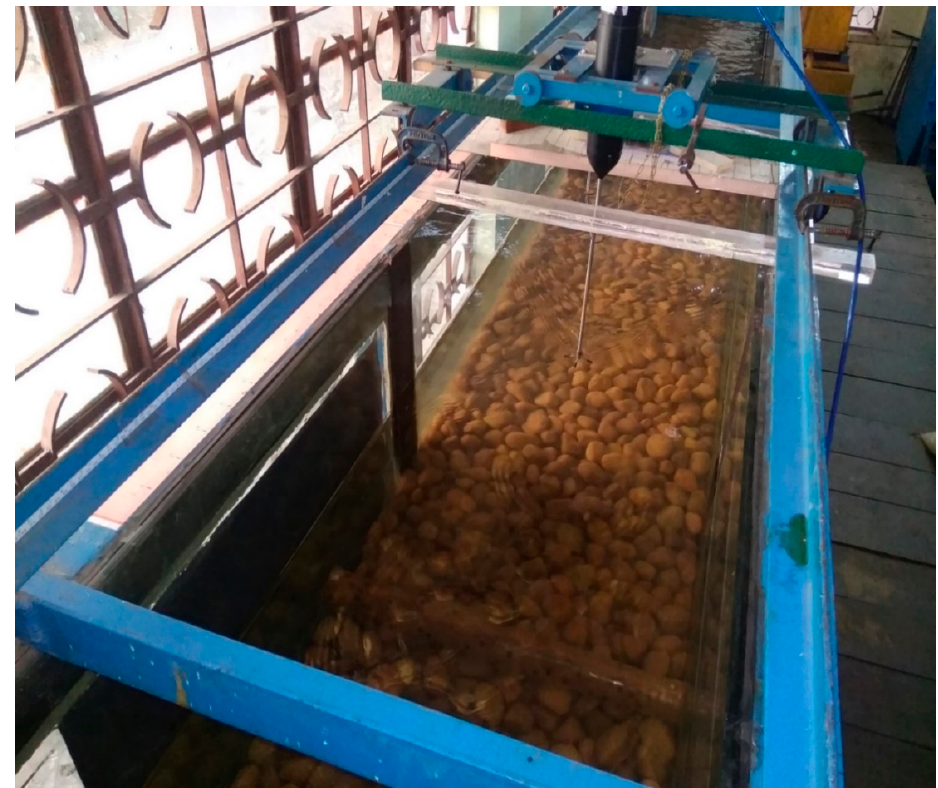
Figure 3. The flume setup for the gravel-bed (GB